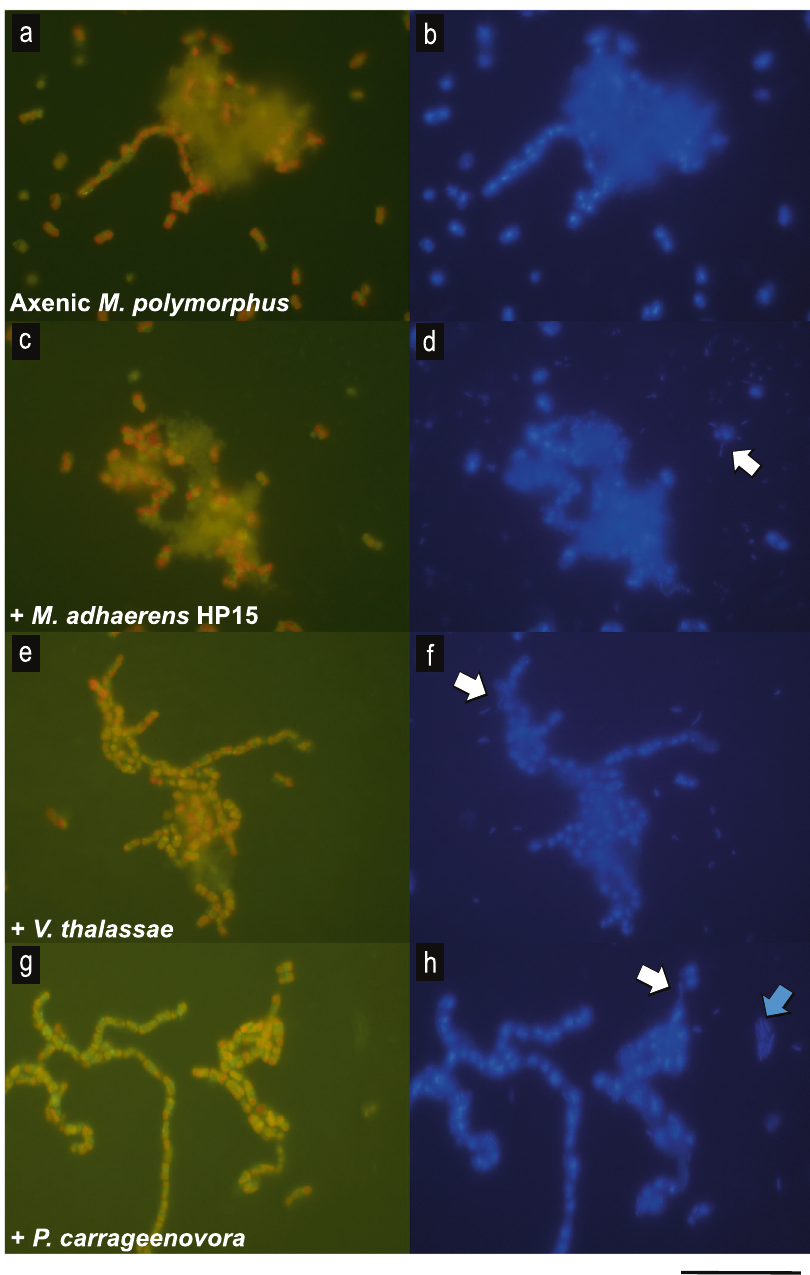
Fig. 3 Microscopy images of microaggregates and attached bacteria. Epi fl uorescence microscopy images of axenic Minutocellus polymorphus ( a , b ) and co-cultures of M. polymorphus and Marinobacter adhaerens HP15 ( c , d ), Vibrio thalassae ( e , f ), and Pseudoalteromonas carrageenovora ( g , h ) under blue ( a , c , e , g ) and UV ( b , d , f , h ) excitation wavelengths. Images were taken during the exponential phases of growth. Red: chlorophyll- a auto fl uorescence, blue: DAPI-bound nucleic acids. White arrows: diatom-attached bacteria; blue arrows: bacterial aggregates. Amorphous material is considered